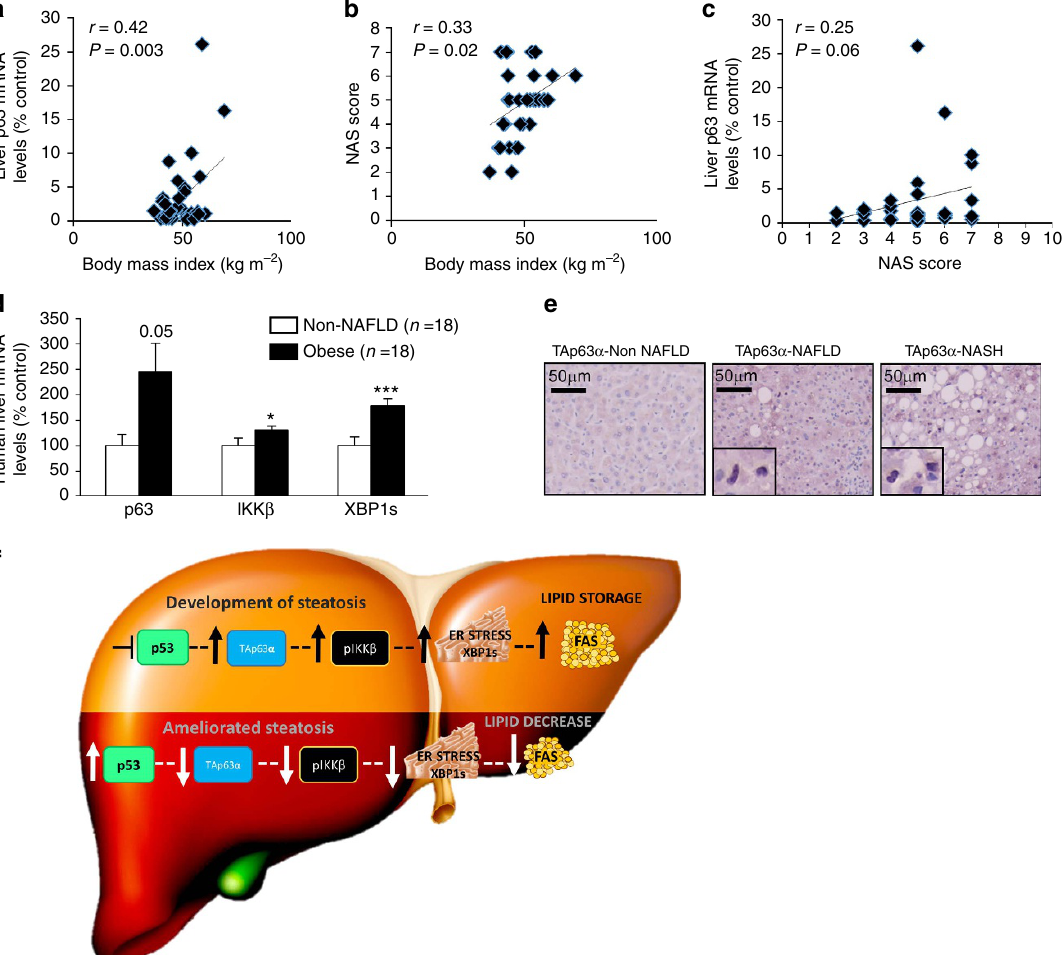
Figure 10 | TAp63 a is up-regulated in the liver of obese patients with NAFLD/NASH. Correlations between ( a ) BMI and TAp63 a ; ( b ) BMI and NAS score; ( c ) TAp63 a and NAS score; ( d ) Liver mRNA levels of TAp63, IKK b and XBP1s in subjects without NAFLD ( n ¼ 18) and with NAFLD ( n ¼ 48). HRPT was used to normalize mRNA levels; and ( e ) Representative photomicrographs of an immunohistochemistry against TAp63 in human liver slices from lean ( n ¼ 11), NAFLD ( n ¼ 23) and NASH ( n ¼ 19) patients. ( f ) Schematic representation of the pathway proposed to modulate lipid metabolism in liver. Data are presented as mean ± standard error mean (s.e.m.). Statistical differences are denoted by * P o 0.05, ** P o 0.01 and *** P o 0.001, was tested using Student t